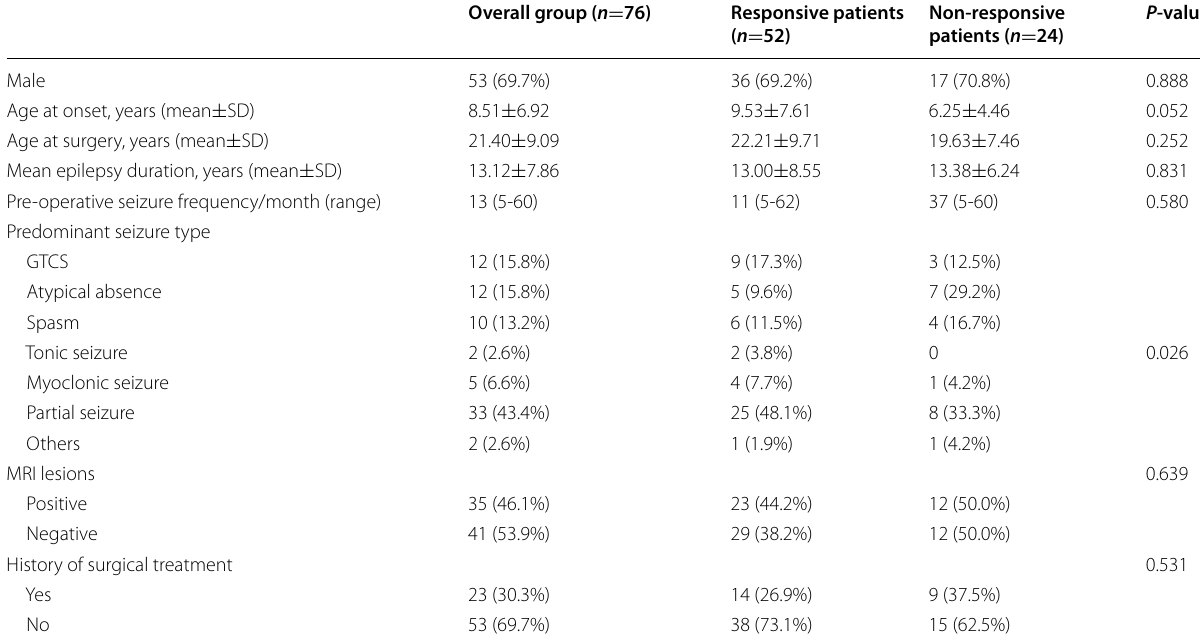
Table 1 Demographic data of the patients